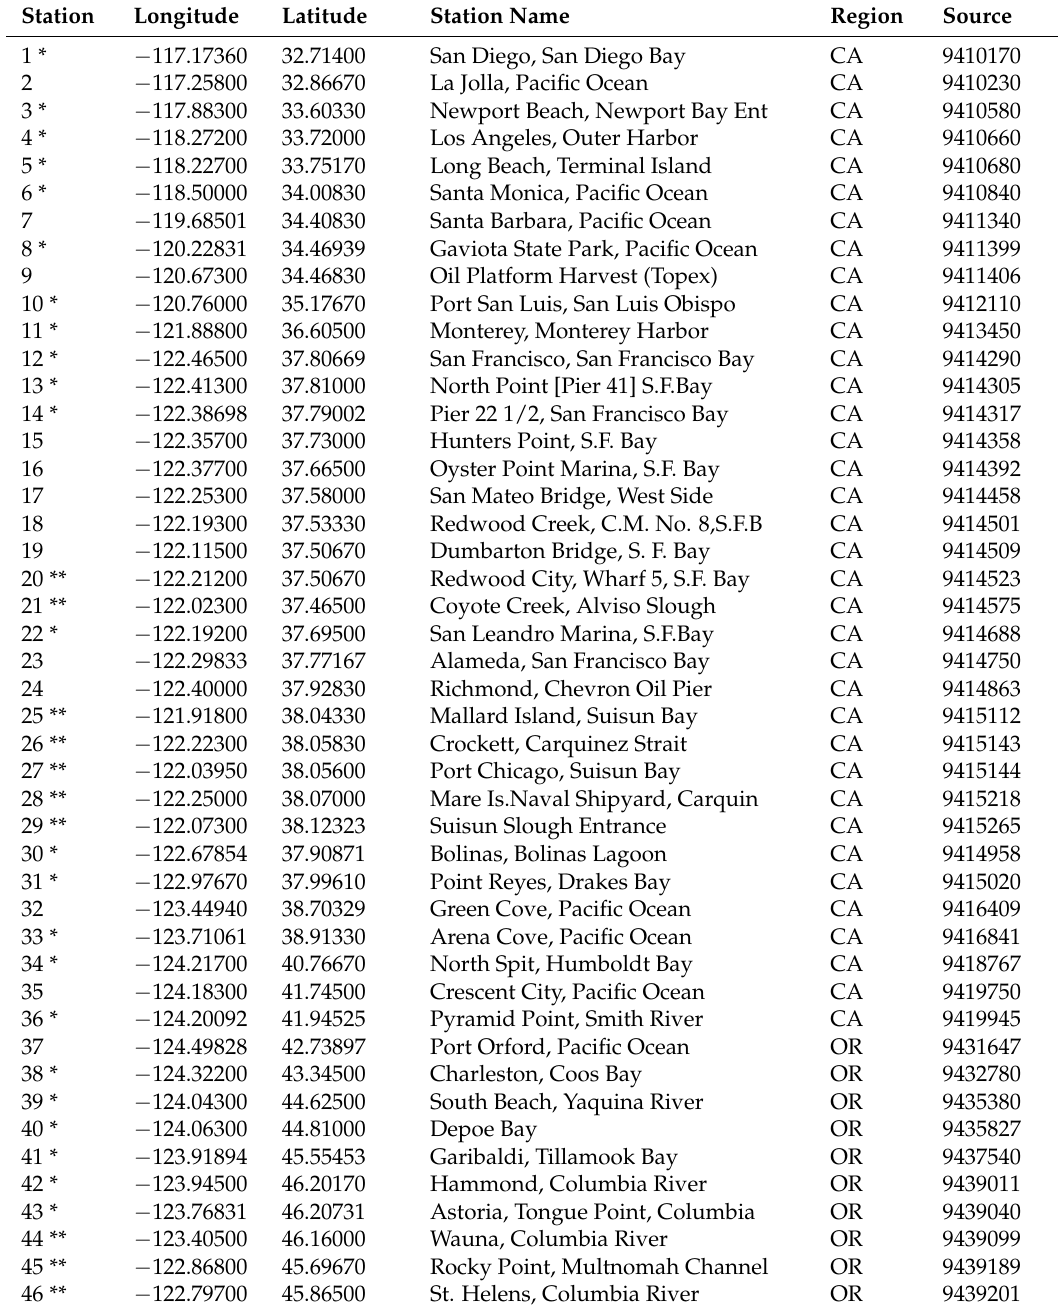
Table A1. Location and source information for validation data. For the first 139 stations, the number in the Source column is the CO-OPS station